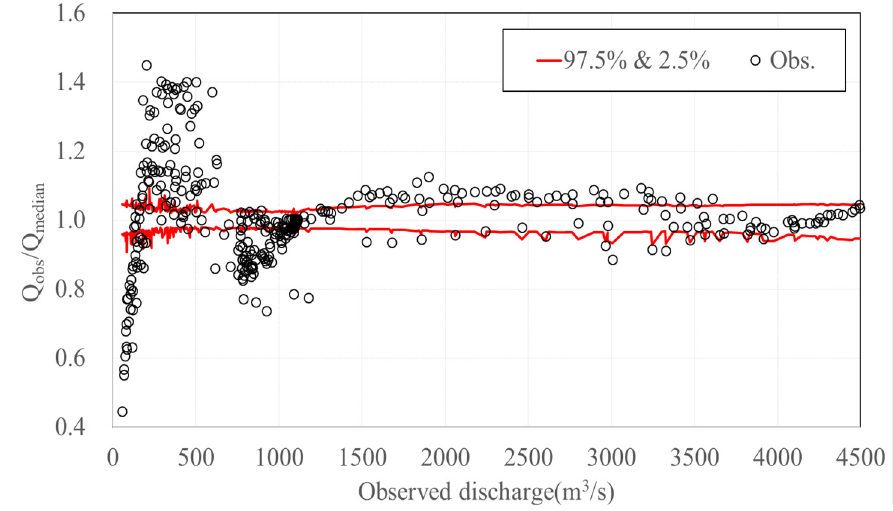
Figure 7. Ratio of median and observed discharge measured using